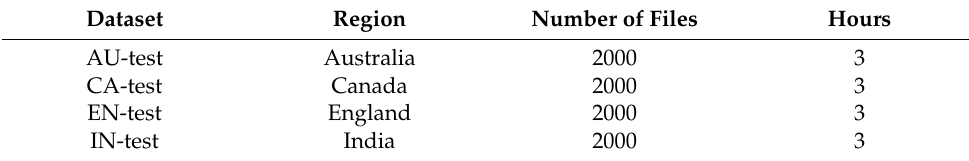
Table 4. Summary of the test